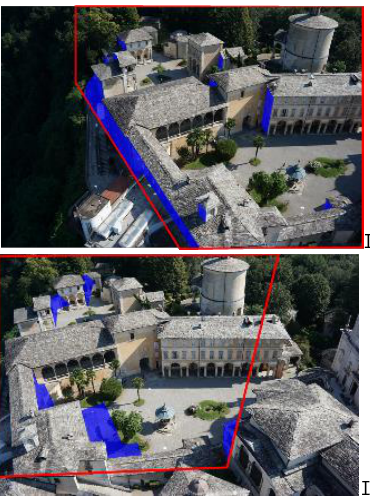
Figure 9. Example of images of two nearest strips in the same flying direction (the same in Figure 8), with underlined an approximated overlapping area (with red borderline) and the respective shadows areas (in blue).